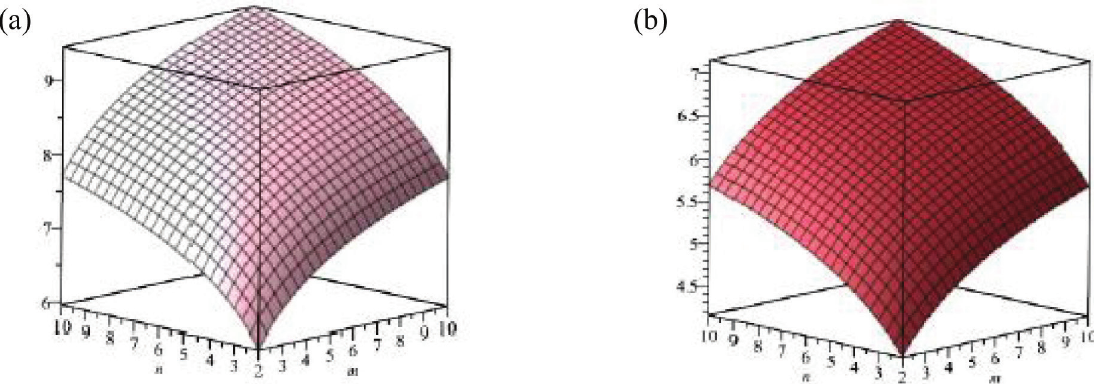
Figure 7: (a) The augmented Zagreb entropy, (b) the Balaban